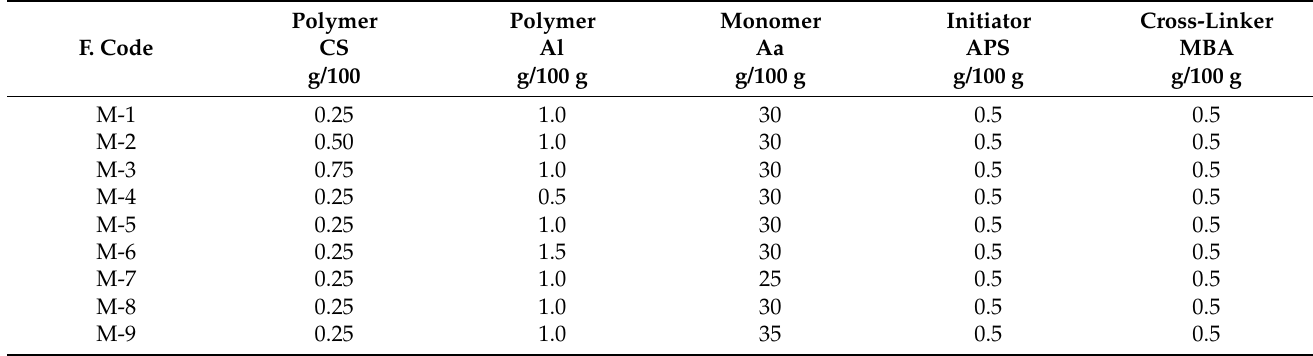
Table 1. Chemical composition for formulation of CS/Al-g-pAa